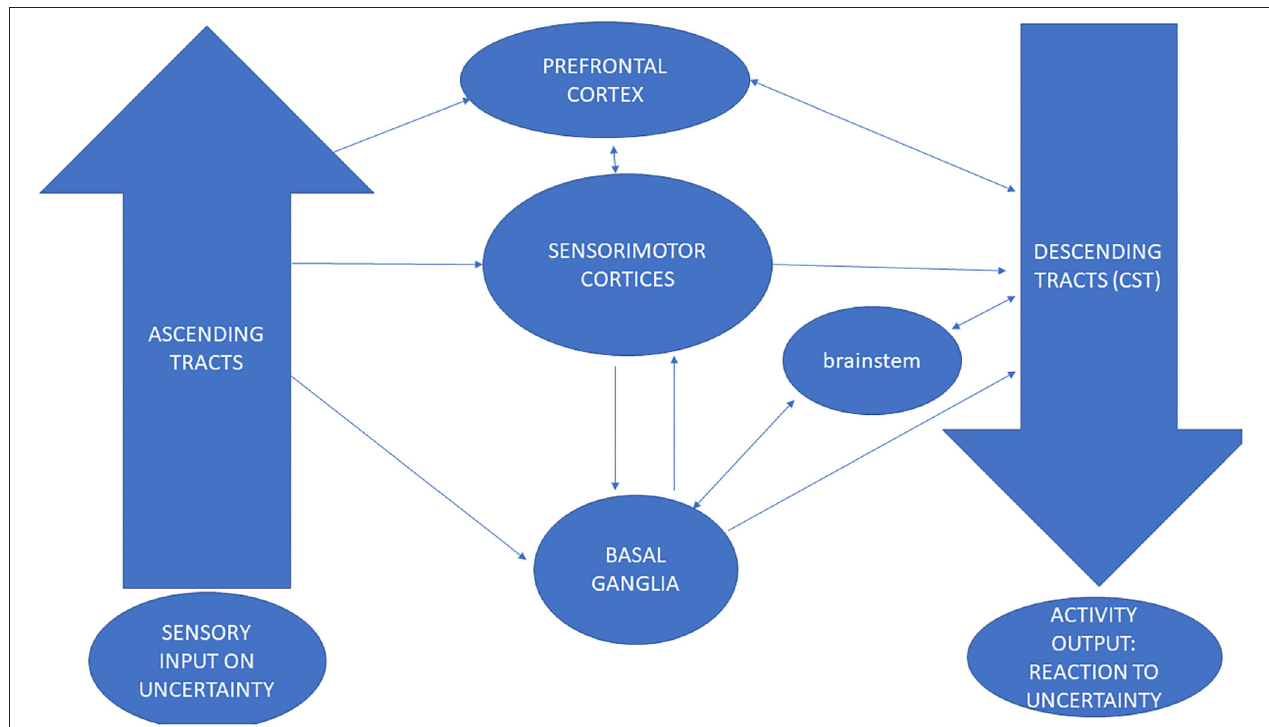
FIGURE 2 | The involvement of sensorimotor circuits in processing and filtering uncertainty cognitions in the healthy brain: The Sensorimotor-Cognitive-Integration-Circuit (SCIC).